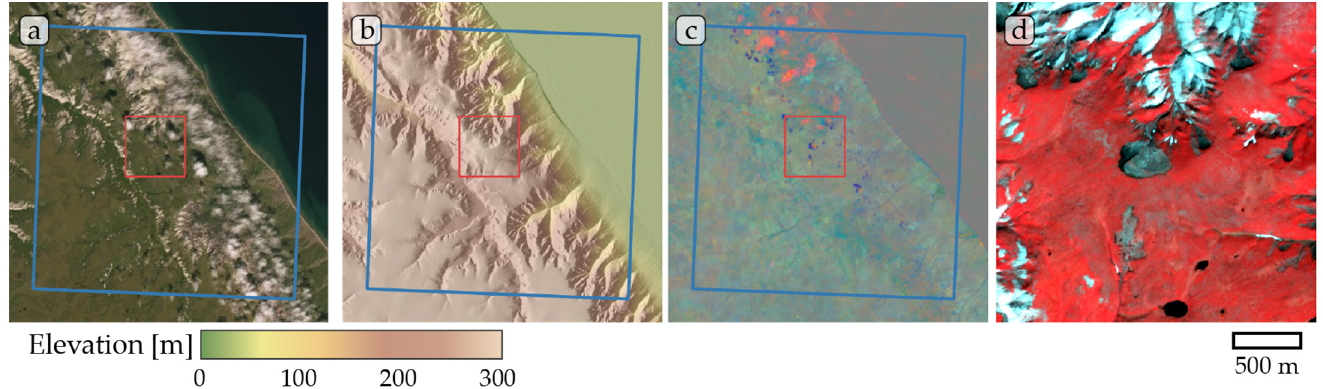
Figure A5. Study site Horton 02. ( a ) ESRI satellite layer, ( b ) ArcticDEM superimposed with hillshade, ( c ) Tasseled Cap trend visualization, ( d ) PlanetScope satellite image (NIR-R-G) acquired on 27 July 2019. Blue box, 10 × 10 km study site. Red box detailed view of ( d ).